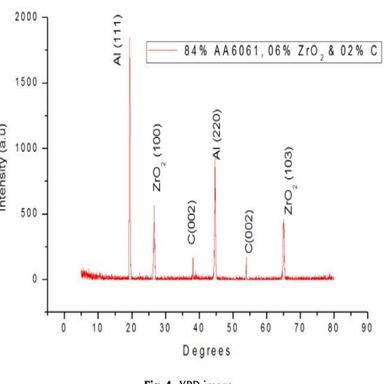
icrostructure of FSW joints, Fig. 6.Cross Weld micr hardness at various zone.